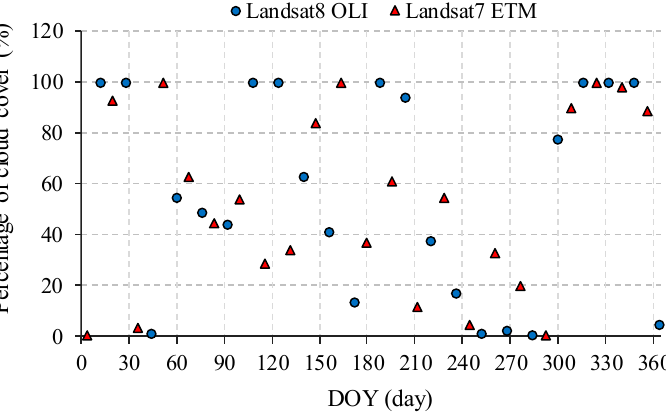
Figure 3. Percentages of cloud cover present in the Landsat images (path / row 121 / 40) from 2015 used in the study.